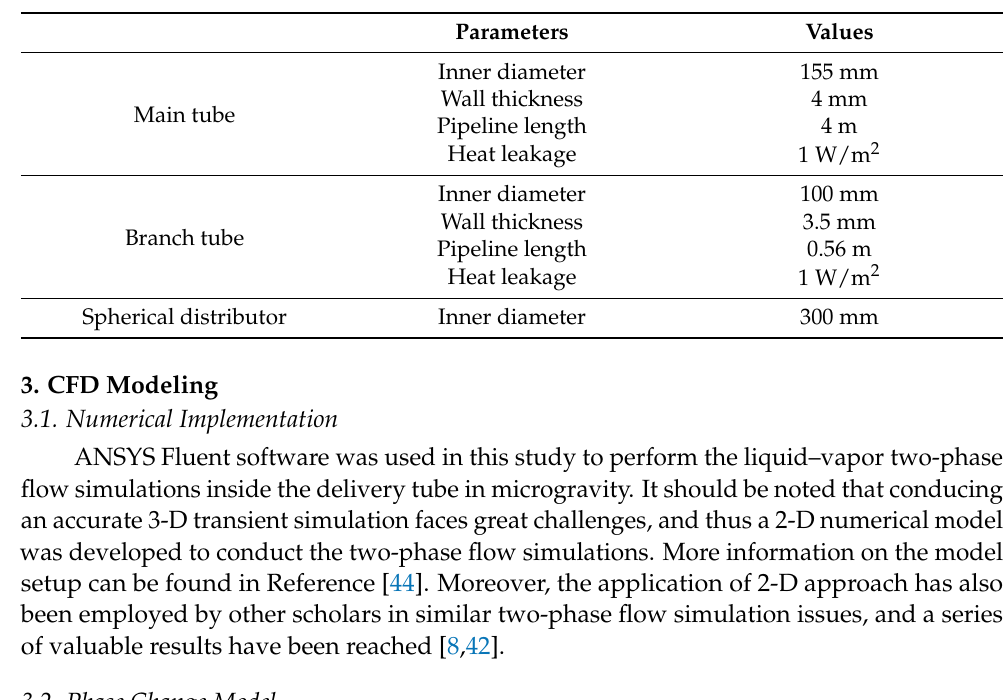
Figure 1. Schematic diagram of LH 2 pipeline in the cryogenic upper stage. Table 1. Main parameters of LH 2 delivery